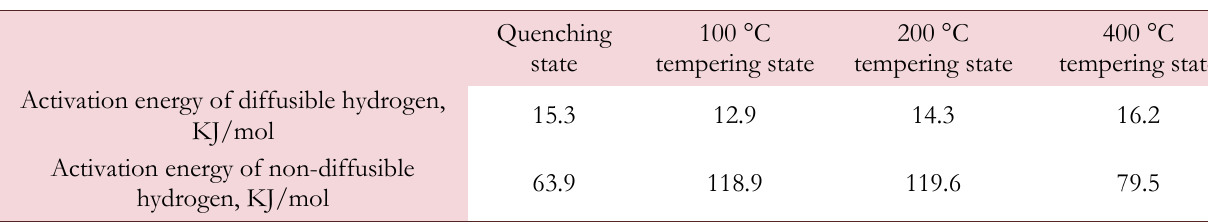
Table 6: Hydrogen trap activation energy of experimental materials.